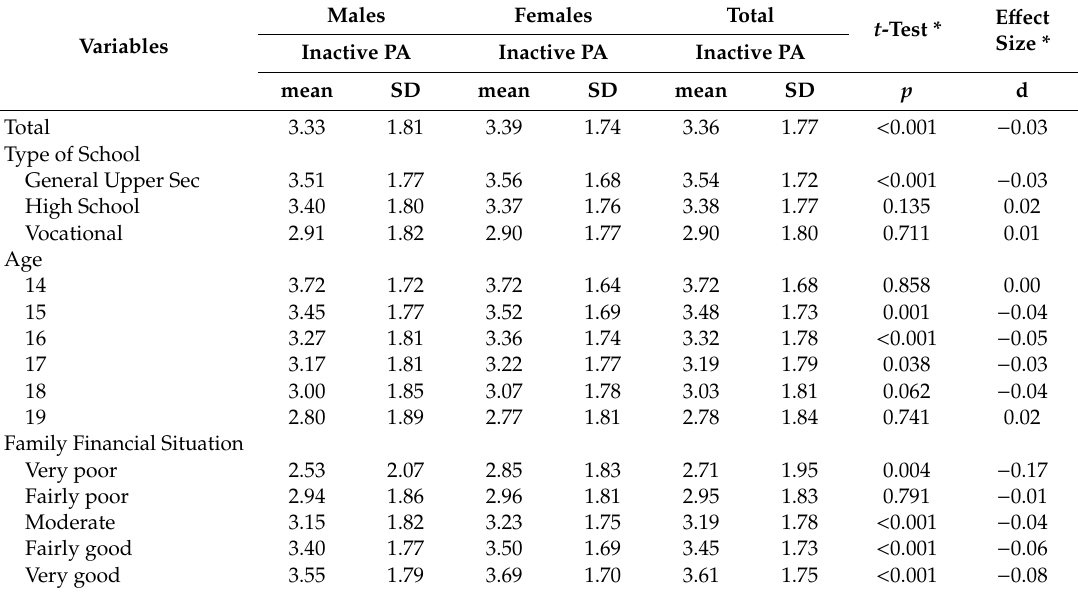
Table 3. Association of covariates and unadjusted days of physical activity of inactive group.